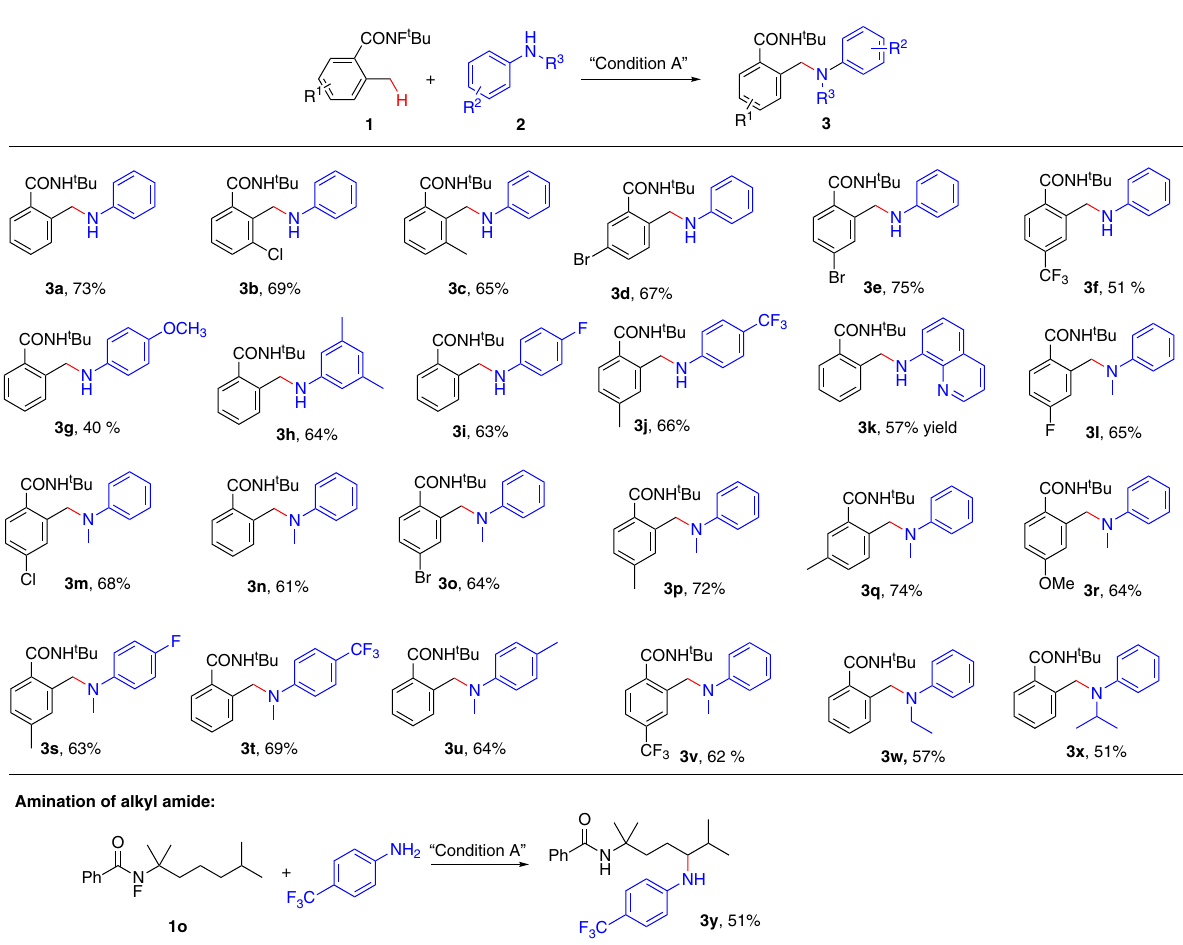
Fig. 2 Substrate scope of sp 3 C – N coupling reactions. All reactions were conducted in 0.2 mmol scale. Yields referred to isolated yields.